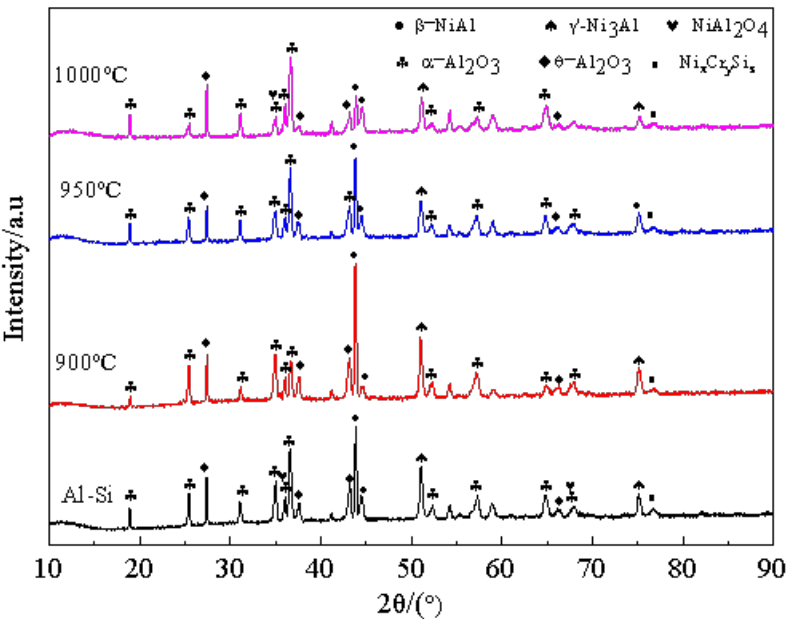
Figure 7. XRD patterns of Al-Si coatings at different pre-oxidation temperatures after constant temperature oxidation at 1000 ◦ C for 300 h.